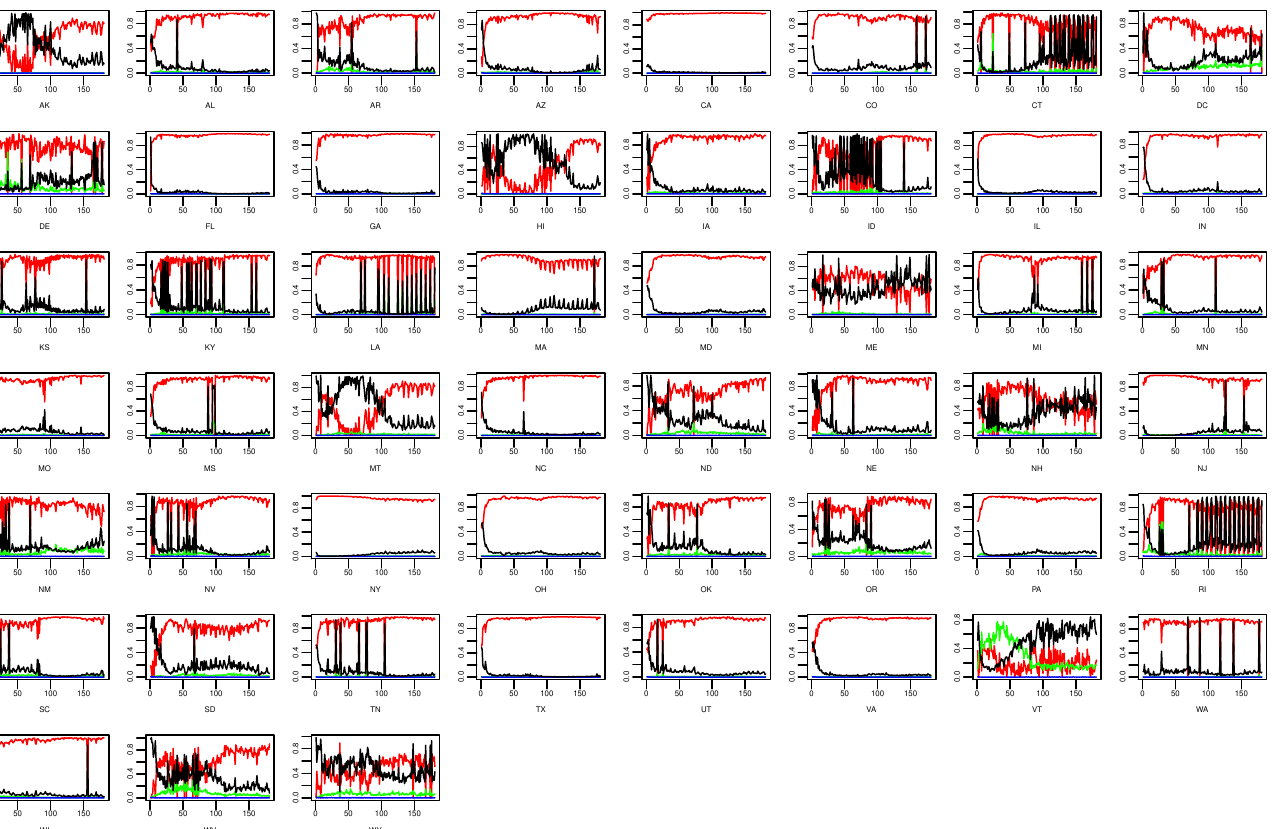
Figure 6. State-level daily percentage of daily confirmed cases with respect to the epidemic-within, endemic-between, epidemic-boosted, and endemic components, which are indicated by red, green, blue, and black lines,